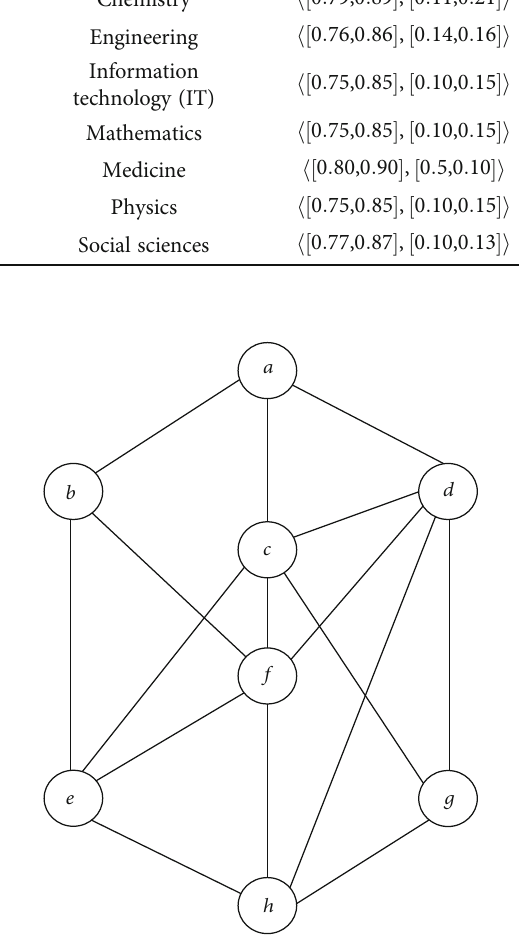
Figure 8: The scienti fi c communities IVIFG. Table 10: IVIFNs of relations between scienti fi c communities. Edges IVIFNs Edges